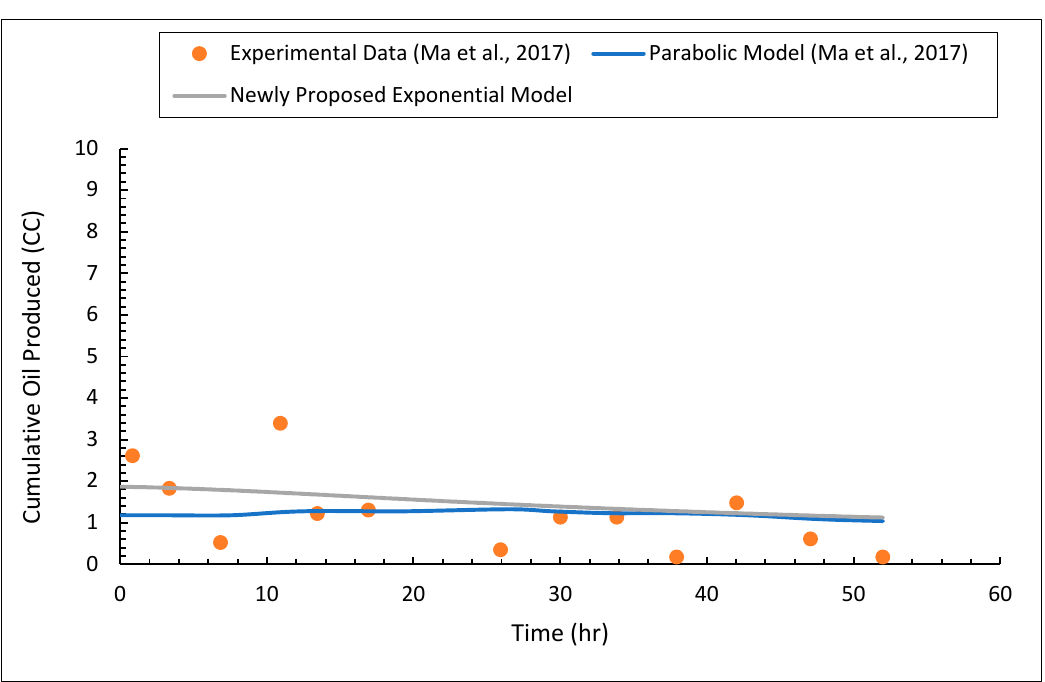
Figure 28. Comparison of the oil production rate estimated by the newly proposed exponential model, experimentally measured oil production rate [3], and oil production rate estimated by the parabolic model proposed by Ma et al. [3] in test #4.